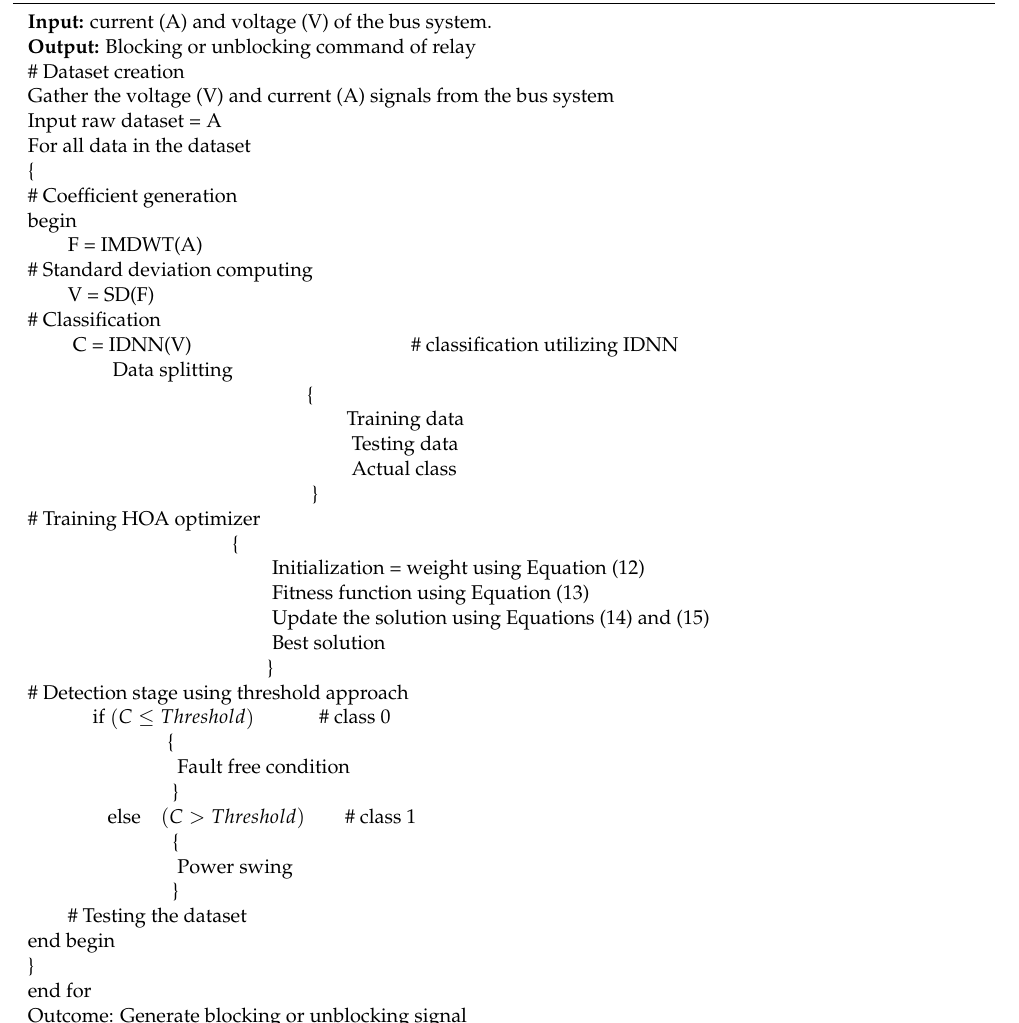
Algorithm 1: Pseudocode of Proposed